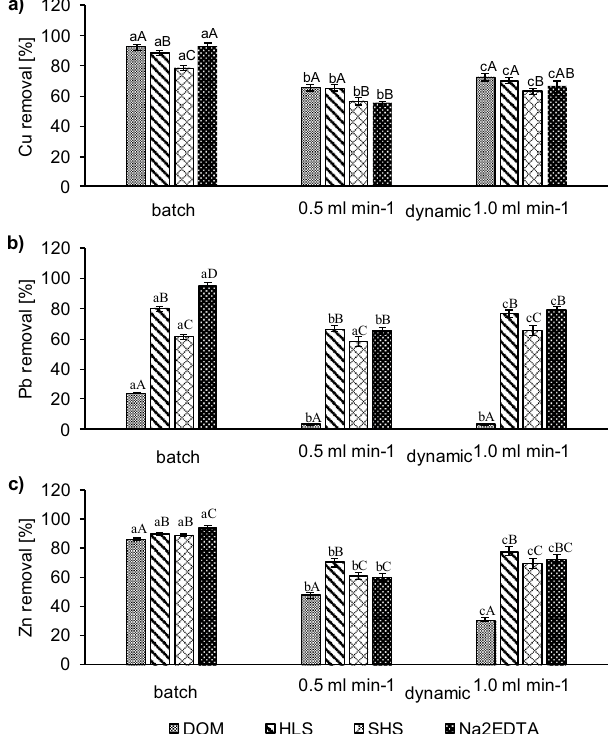
Figure 2. Comparison of the efficiency of metal removal from soil under batch and dynamic washing with DOM, HLS, SHS and Na 2 EDTA: ( a ) Cu, ( b ) Pb, and ( c ) Zn. Different letters indicate statistical differences at p < 0.05 (Statistica 13.1) between the efficiency of metal removal for different washing conditions (abc) and between the efficiency of metal removal with washing agents for a given washing condition